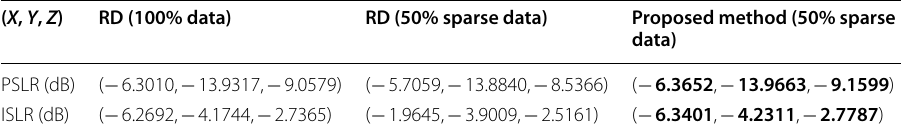
The optimal values are shown in bold